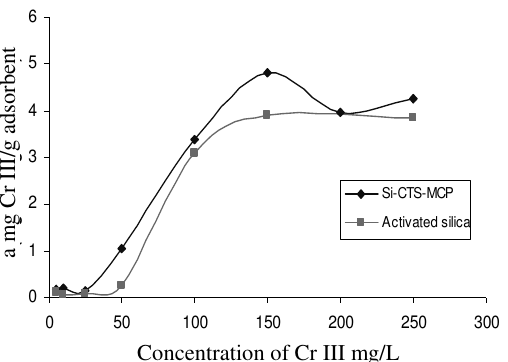
Figure 9. Effect of the initial concentration of chromium(III) on adsorption of chromium(III) onto 1 g of Si-CTS-MCP and activated silica.